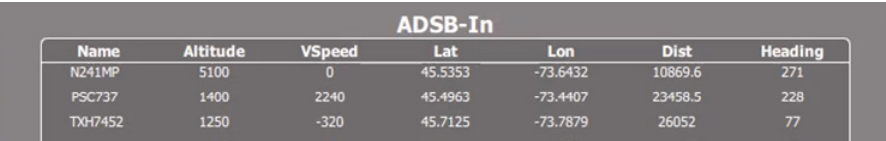
Table 1. Slow attack AGC parameters and related registers and their default values.